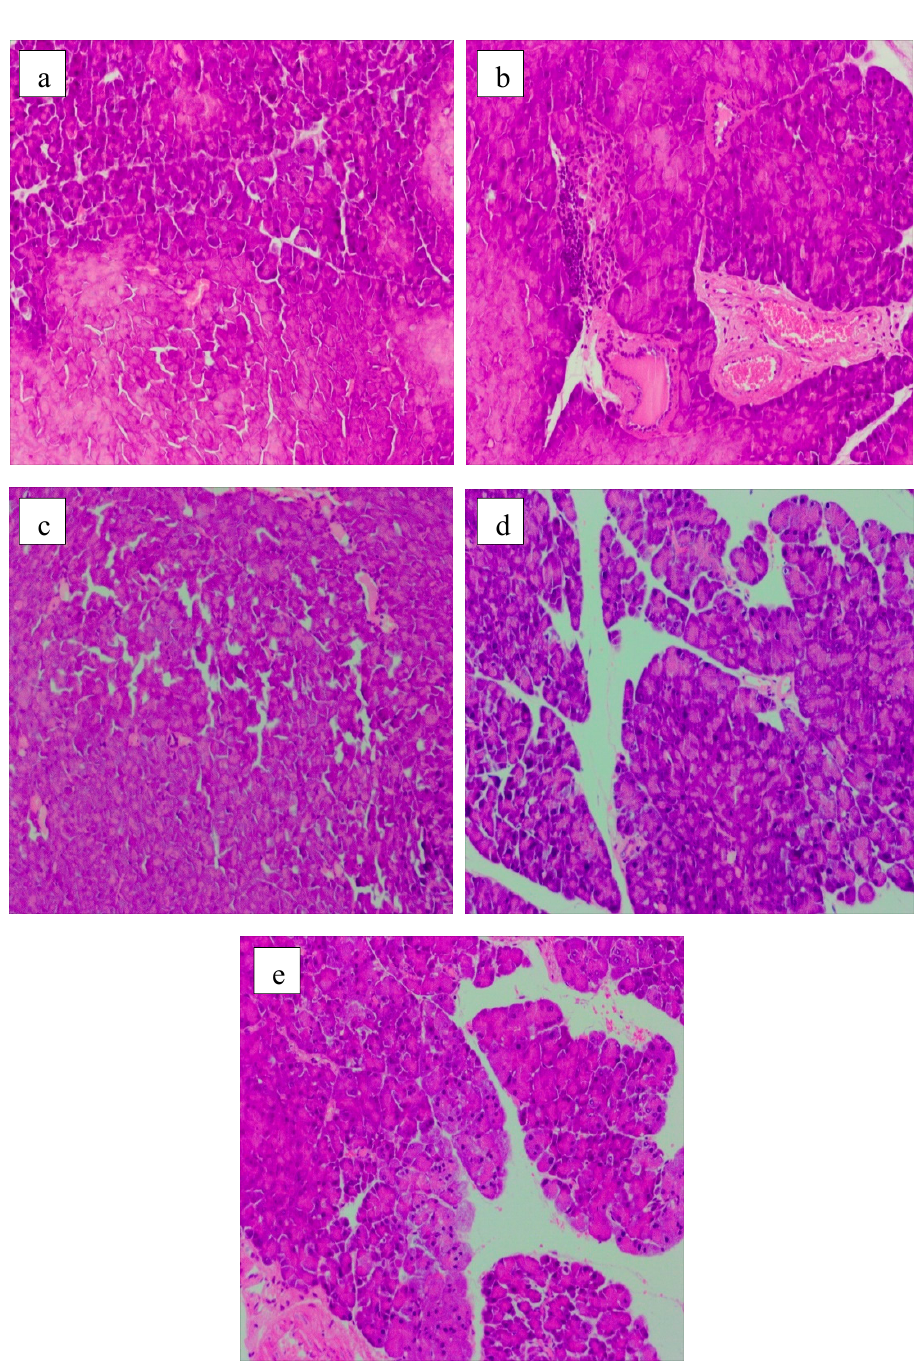
Figure 6. Pancreas histology images (HE staining, 100×). ( a ) NG; ( b )MG; ( c )PG; ( d )LP; ( e )HP.